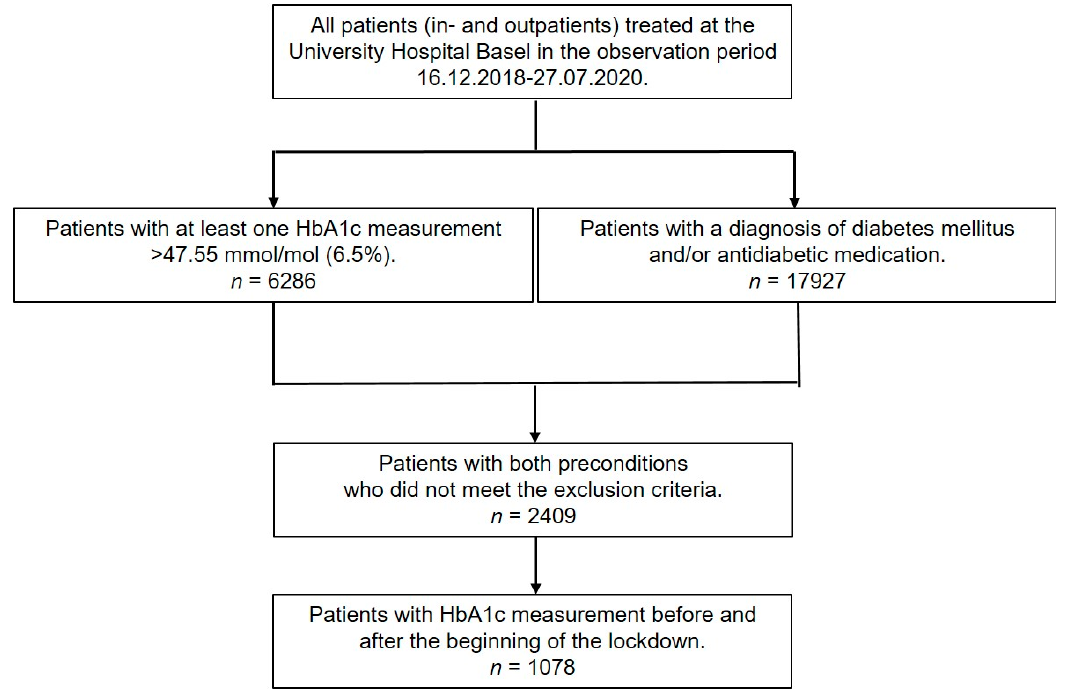
Figure 1. Flow diagram showing the numbers of eligible and included